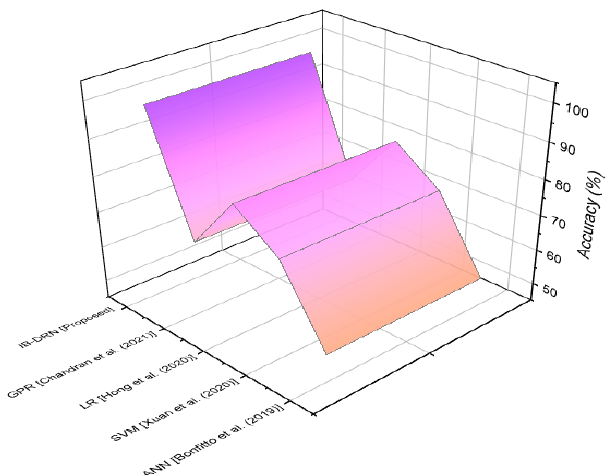
Figure 3. Accuracy outcomes of existing and proposed methodologies [ANN [Bonfitto et al. (2019)], SVM[Xuan et al. (2020)], LR[Hong et al. (2020)], GPR [Chandran et al. (2021)]].